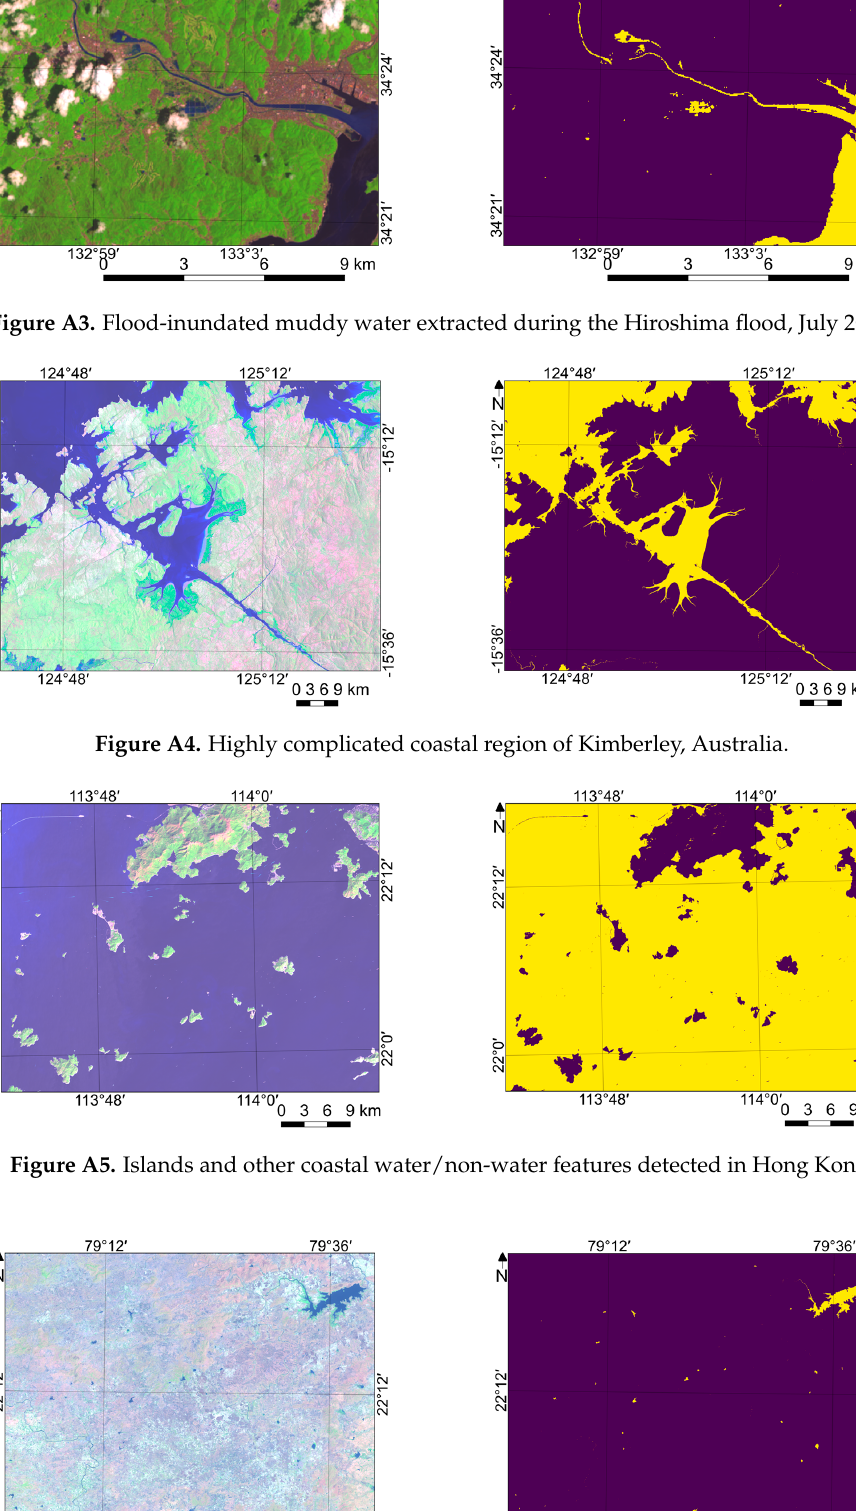
Figure B7. Water/non-water region estimation using Landsat-8 image collected on 2016-10-30. References 1.